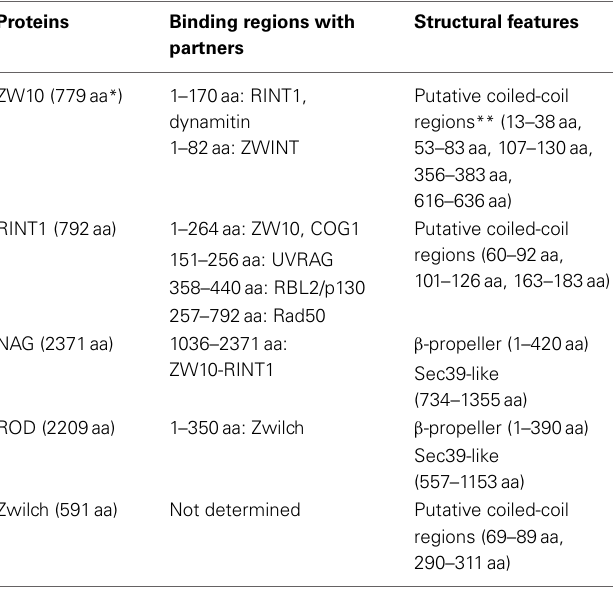
Table 1 | Features of subunits of the human NRZ and RZZ